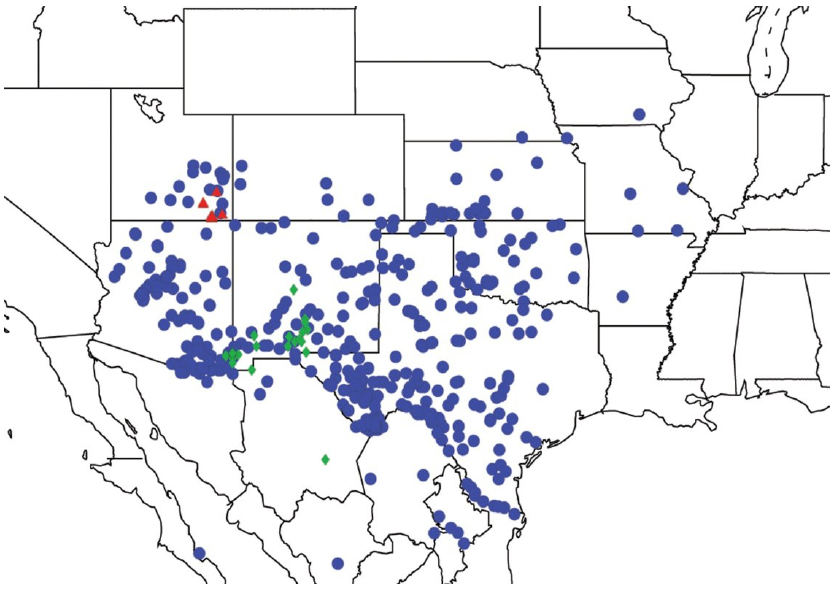
Figure 27. Distribution of Beameria venosa (blue circles), B. wheeleri (green diamonds) and B. ansercollis (red